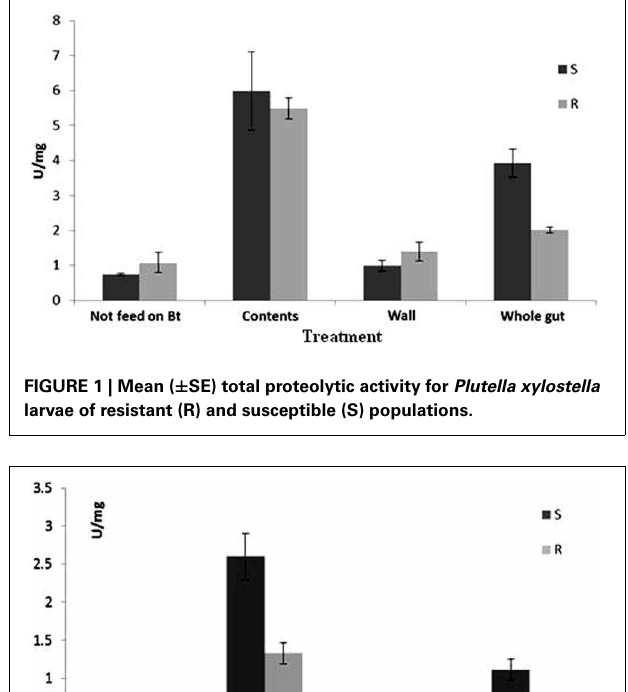
leaves ( t = 2 . 61, df = 4, P = 0 . 06). When protease activity